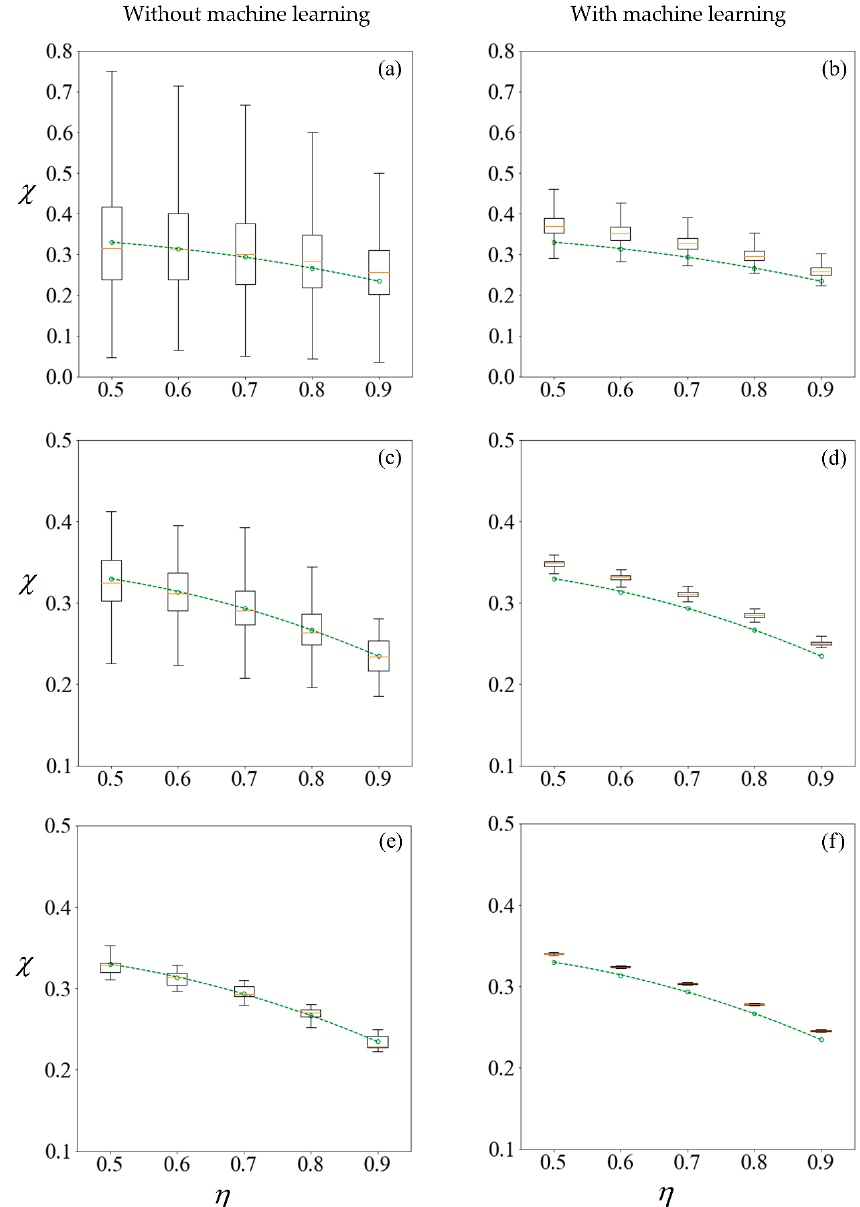
Figure 11. Boxplots representing results computed ( left column ) and predicted ( right column ) from training sets of size 100, 1000, and 10,000 samples in the first row ( a , b ); second row ( c , d ) and third row ( e , f ), respectively. The circle markers are results computed from 10 5 samples, while the dashed-line is the best fit polynomial. The sperm cells are not subjected to any applied field. The machine learning model makes predictions on the remainder of the 100,000 samples less those used for training.